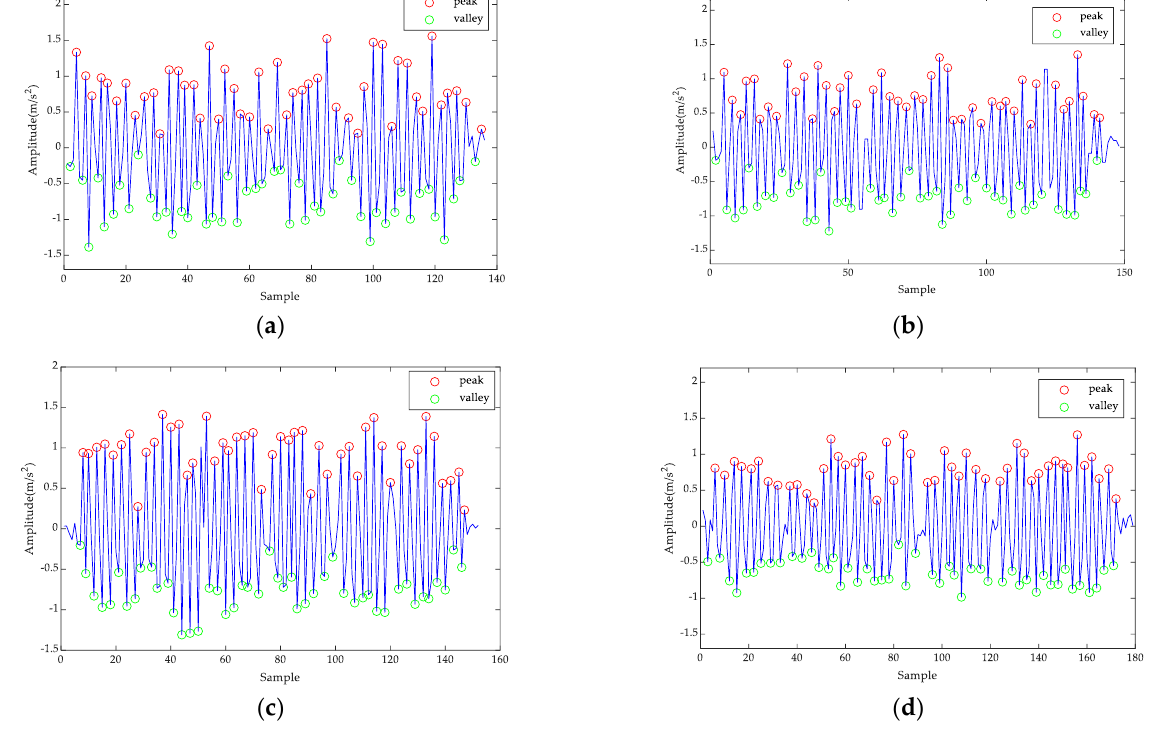
Figure 7. Peak and valley detection results with Honor60, VivoY85a, and two different height pedestrians in the first scene. ( a ) Volunteer #1 with a VivoY85a cell phone. ( b ) Volunteer #2 with a VivoY85a cell phone. ( c ) Volunteer #1 with an Honor60 cell phone. ( d ) Volunteer #2 with an Honor60 cell phone.